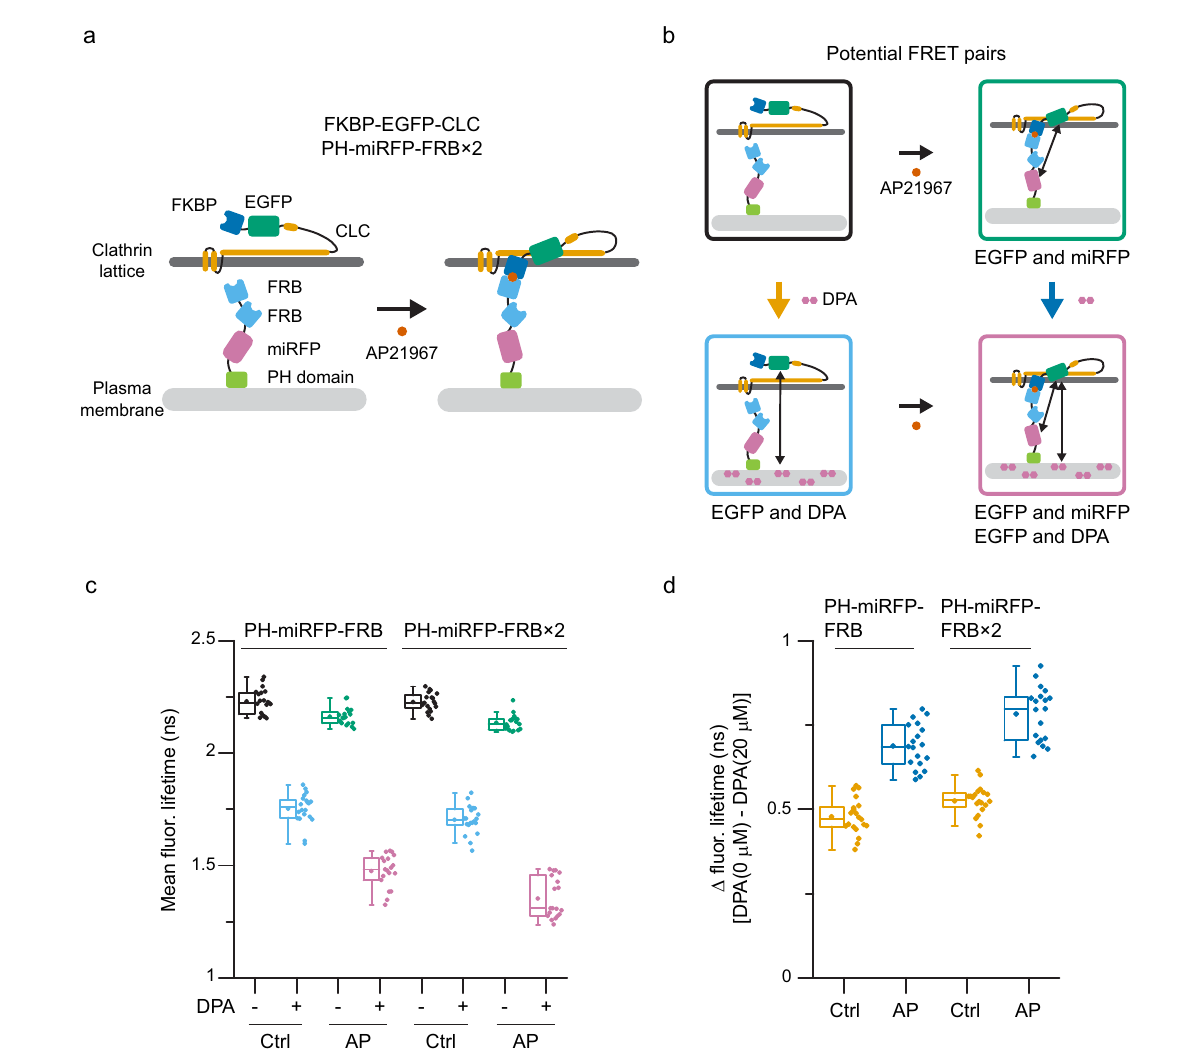
Fig. 4 | Manipulation of CLC N-terminal position using a chemically inducible dimerization system. a Schematic models of the chemically inducible FKBP/FRB dimerization system. FKBP is attached to the N-terminus of CLC, and two FRBs (FRB×2) are attached to the C-terminus of PH domain from PLC δ 1. A rapamycin analog, AP21967, induces heterodimerization between FKBP and the T2098L mutant of FRB. b Potential FRET pairs without or with AP21967 treatment either absence or presence with DPA. c Fluorescence lifetime measurements were per- formed on unroofed membranes of HeLa cells expressing FKBP-EGFP-CLC either